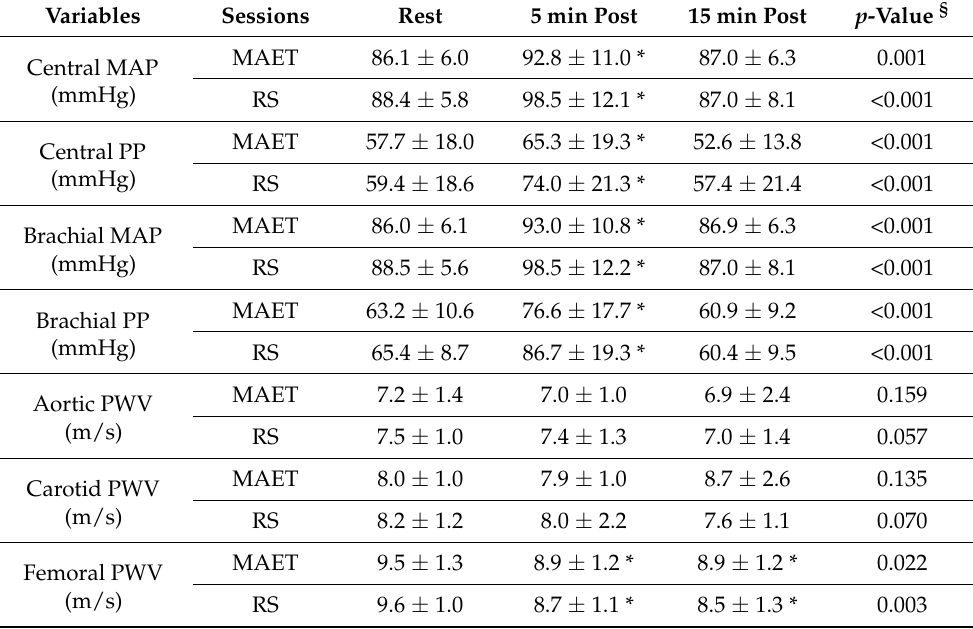
Table 3. Comparison of arterial stiffness and hemodynamic indices at rest and following maximal aerobic exercise test and a rescue simulation in 38